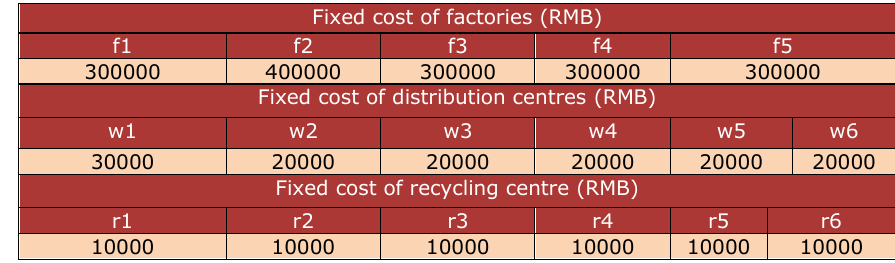
Table 3. The Fixed Cost of